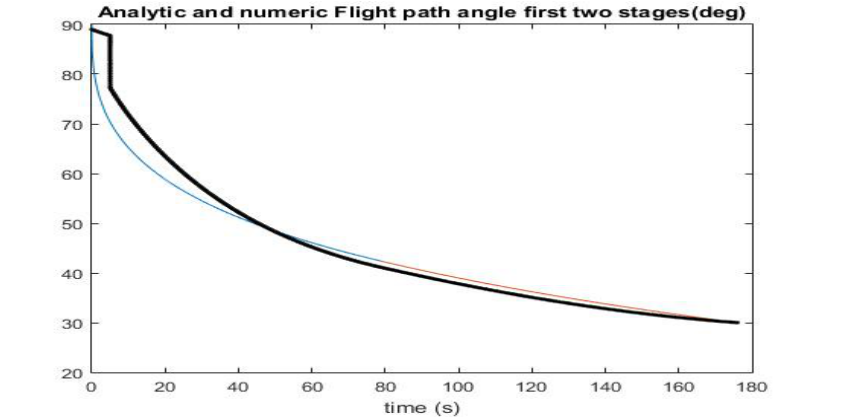
Figure 7. The flight-path angle plot: analytic and numeric results during gravity-turn arc. Numerical flight-path angle of the first and second stage is in black, analytic flight-path angle of the first stage is in blue and second stage in orange